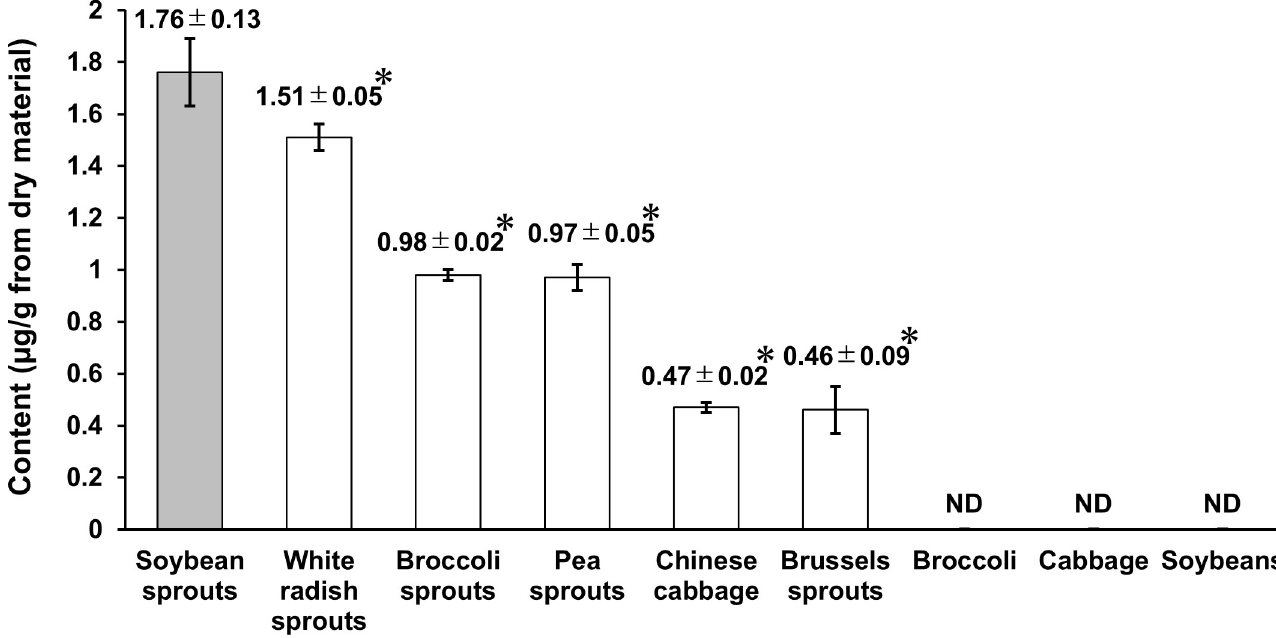
Fig 3. CM contents in nine vegetables (soybean sprouts, white radish sprouts, broccoli sprouts, pea sprouts, Chinese cabbage, Brussels sprouts, broccoli, cabbage, and soybeans). ANOVA with Dunnett’s test was used to compare the soybean sprout group to the other vegetable groups ( � p < 0.001). The CM content was significantly higher in soybean sprouts than in the other vegetables. Values are means ± SD ( n = 3). ND, not detected.